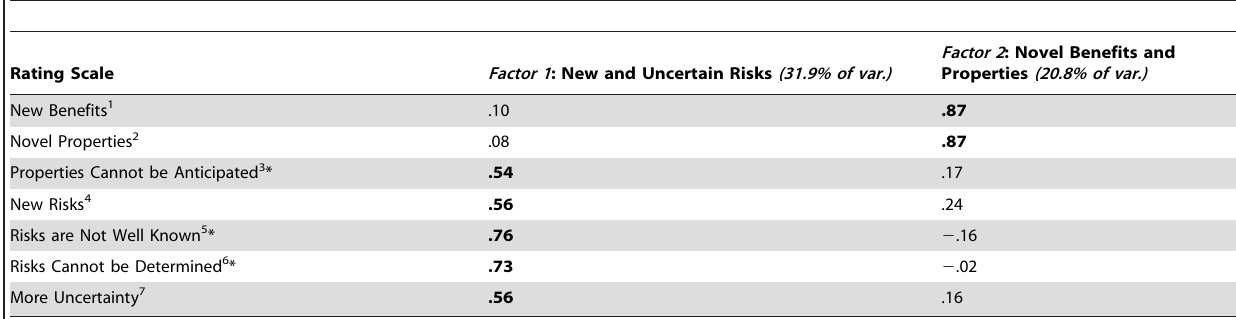
Table 2. Loadings from a principal components analysis over seven rating scales averaged across individuals (VARIMAX rotated solution).